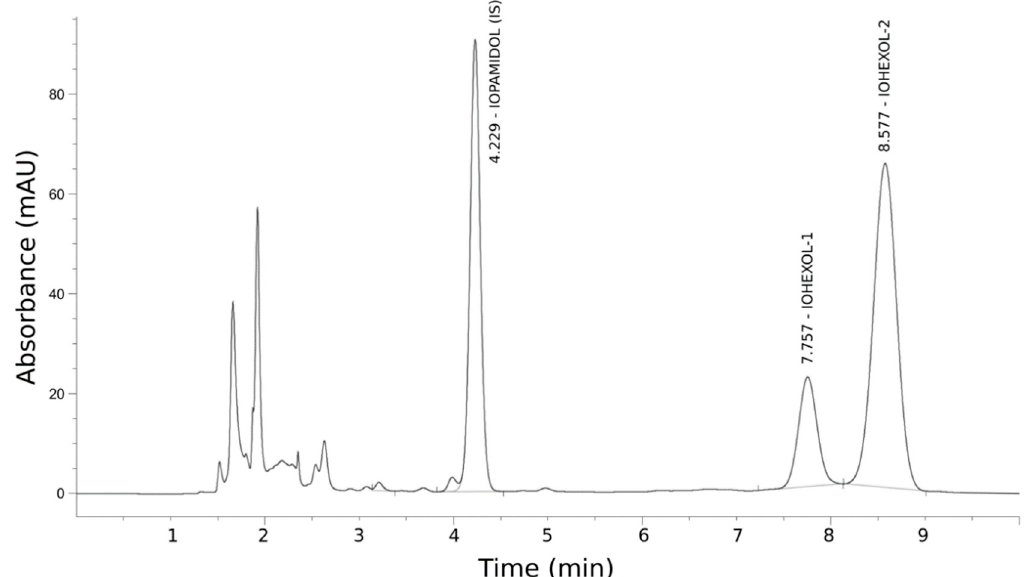
Figure 1. HPLC–UV chromatogram of plasma sample 120 min after iohexol administration.